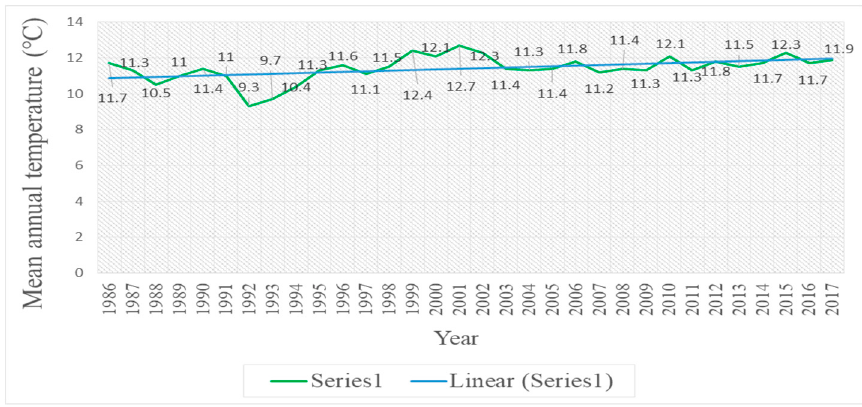
Figure 5. Temperature values of the Lake Urmia from 1986 - 2017.